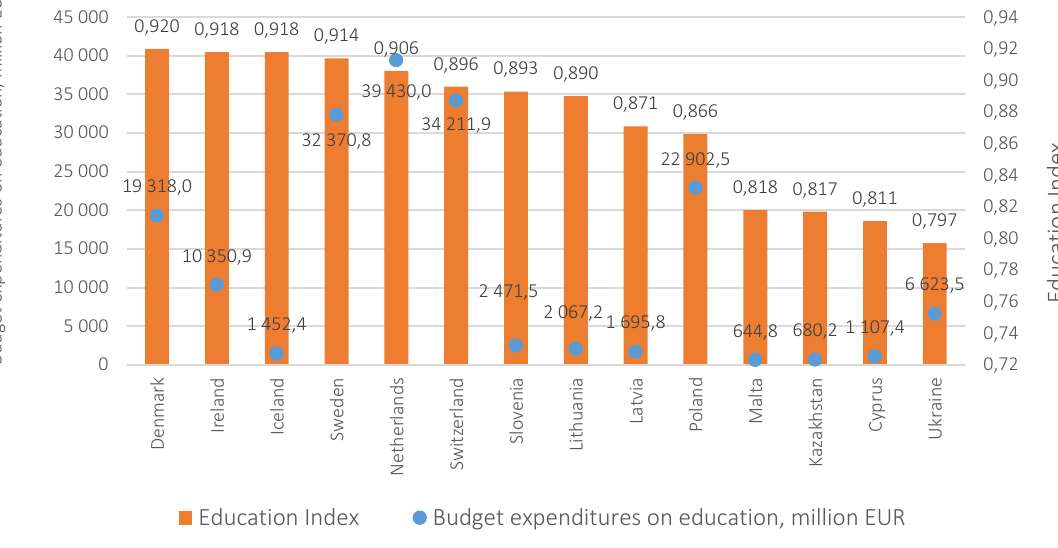
Figure 1. Education index and expenditures on